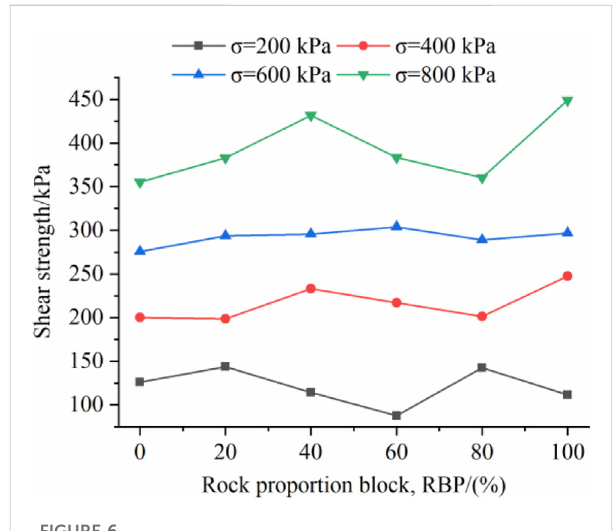
FIGURE 6 Shear strength of S-RM samples with various